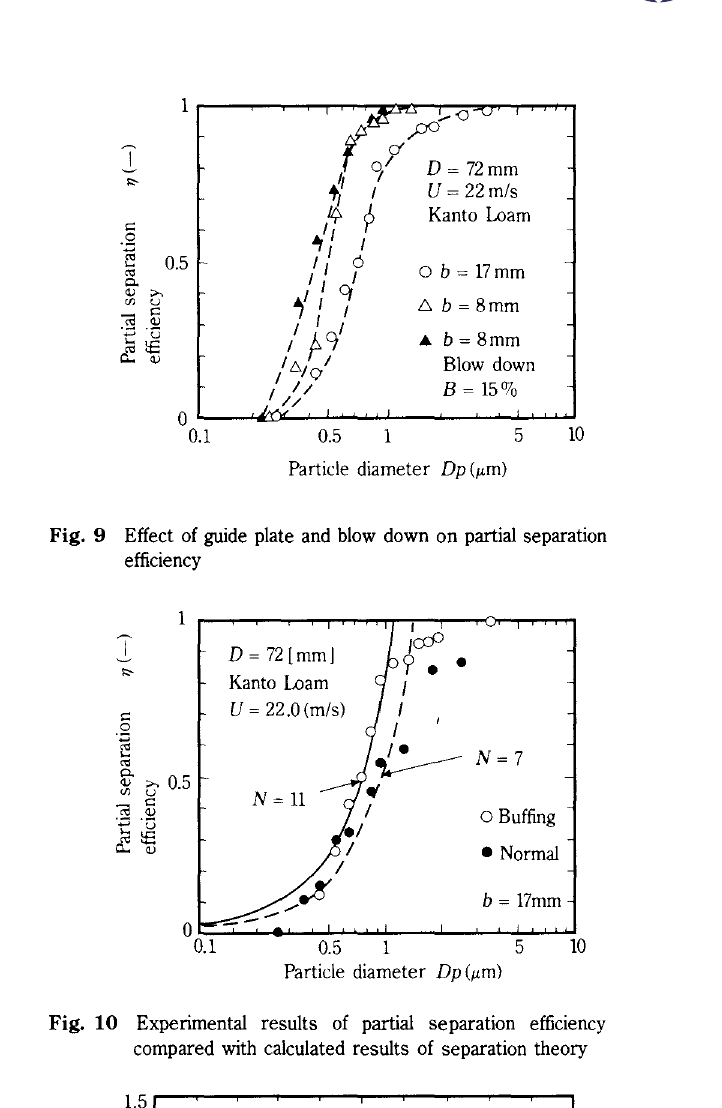
Fig. 10 Experimental results of partial separation efficiency compared with calculated results of separation theory